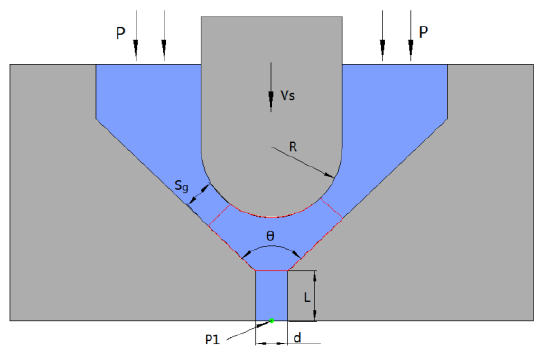
Figure 4. Geometric model of the needle and nozzle.